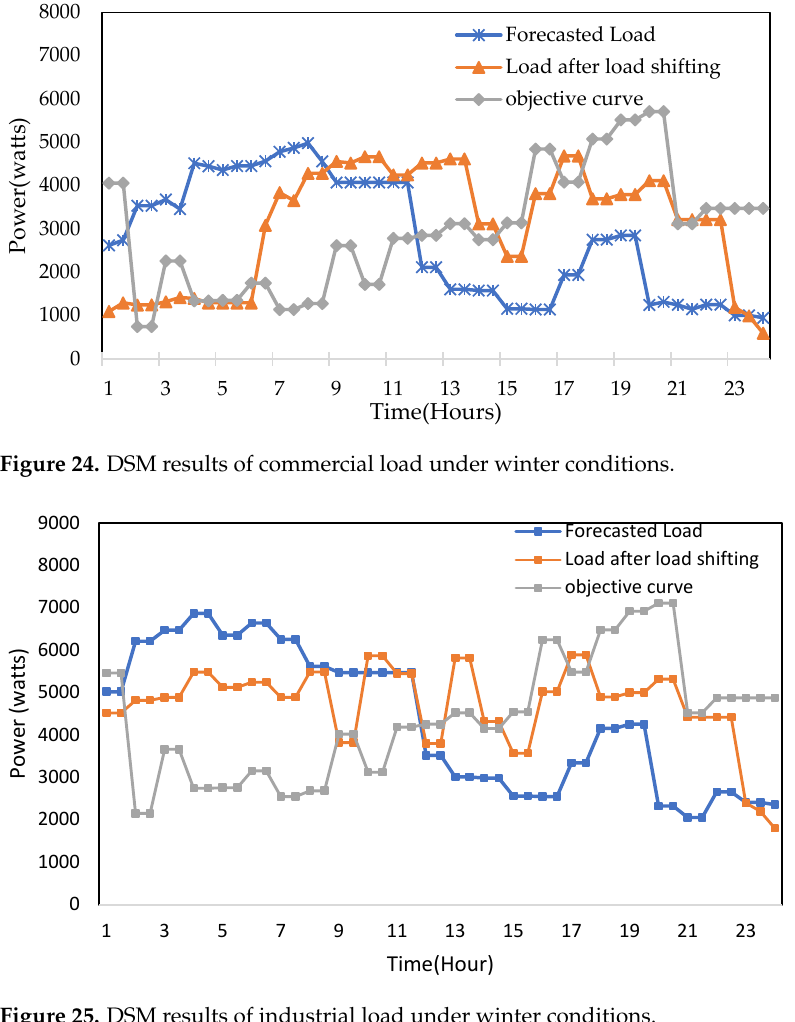
Figure 23. DSM results of residential load under winter conditions.